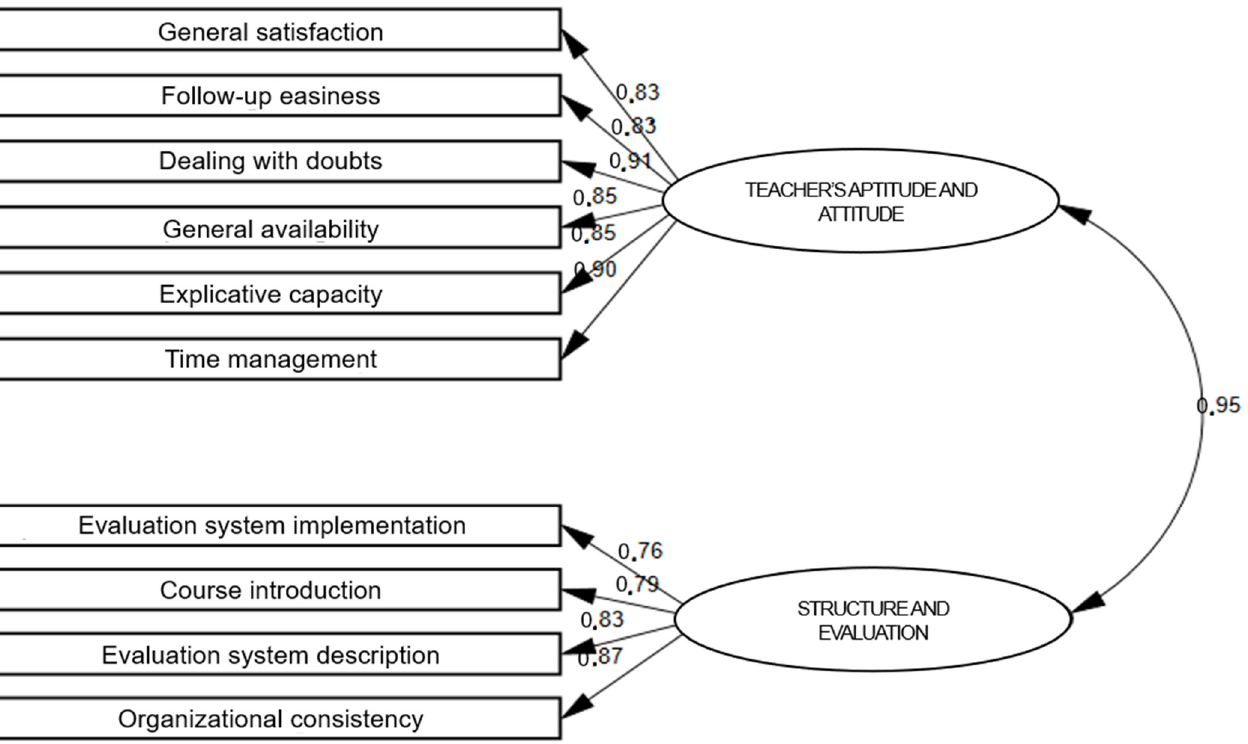
Figure 2. Dimensional model derived from the